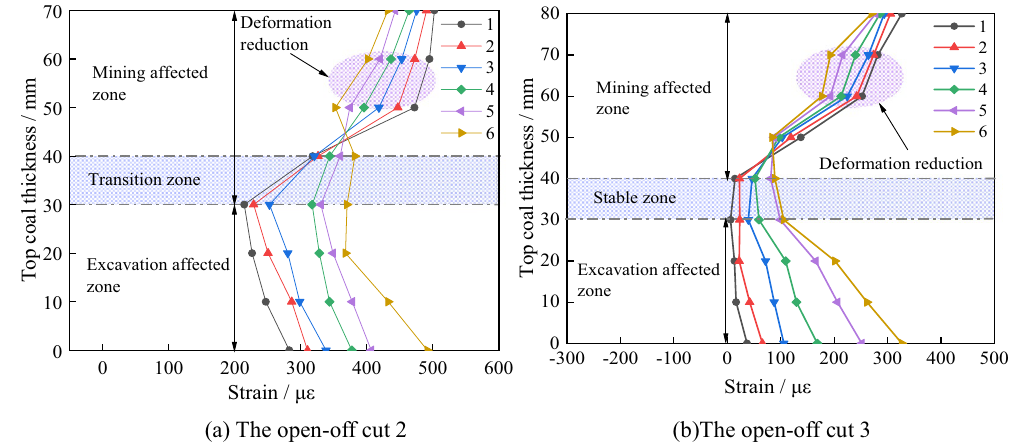
Figure 10. Deformation characteristics of top coal during excavation of open-off cut s 2 and